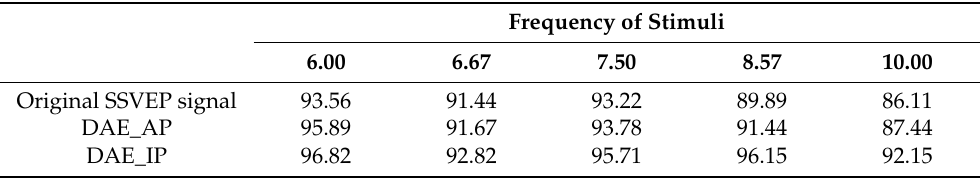
Table 3. The detailed recognition rates (%) for stimuli with different flicking frequencies